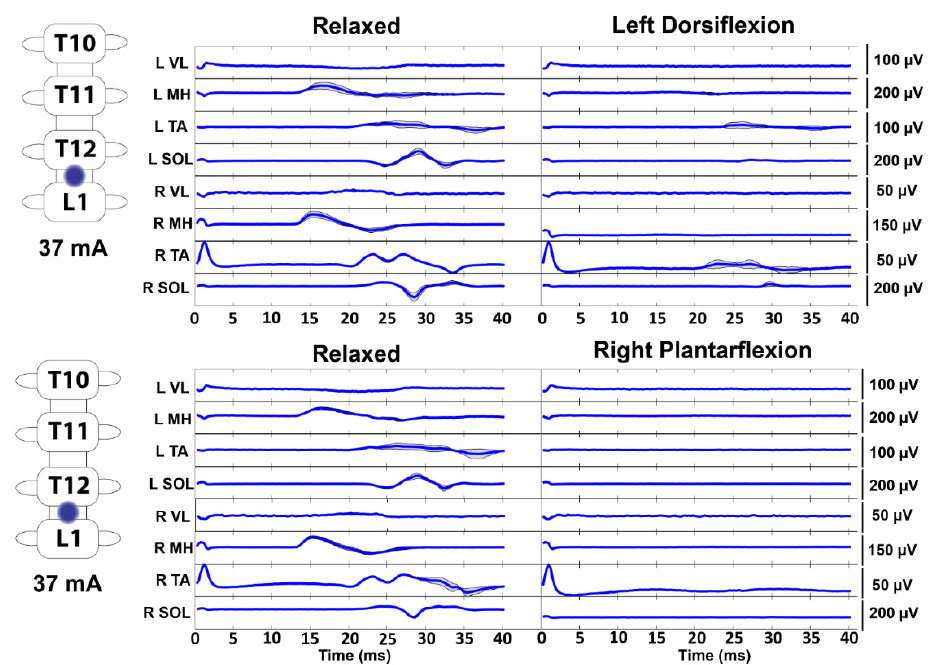
Figure 3. Joint-Specific Movements Decrease Motor-Evoked Responses. During T12/L1 stimulation in a representative study participant, motor-evoked responses were decreased across both the left and right lower extremities during attempts to voluntarily flex the ankle. Stimulation is delivered at the beginning of each trace. The dark line represents the average of at least three stimuli, and the shaded region indicates the ± standard deviation. VL—vastus lateralis, MH—medial hamstrings, TA—tibialis anterior, SOL—soleus, µV—microvolt, V—Volt, and mA—milliamp.